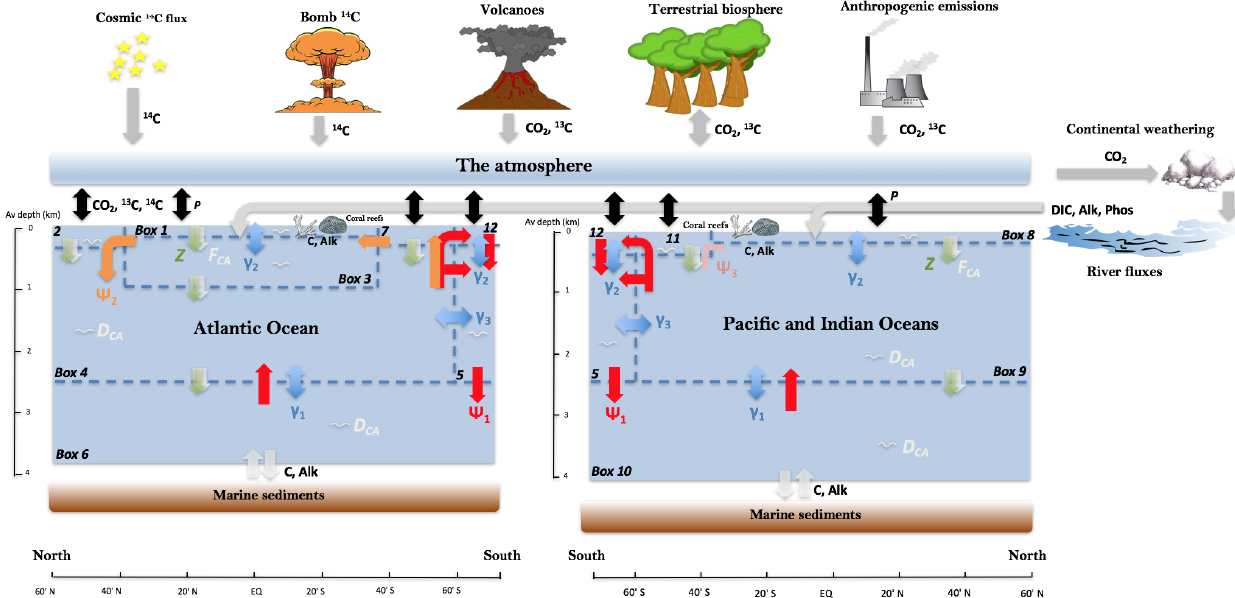
Figure 1. SCP-M configured as a 12-box ocean model plus atmosphere with marine sediments, continents and the terrestrial biosphere. Exchange of elemental concentrations occur due to fluxes between boxes. (cid:57) 1 (red arrows) is global overturning circulation (GOC), (cid:57) 2 (orange arrows) is Atlantic meridional overturning circulation (AMOC). GOC upwelling in both basins is set by default to a 50% split between upwelling into the subpolar and polar Southern Ocean. (cid:57) 3 (pink arrows) is Antarctic intermediate water (AAIW) and Subantarctic mode water (SAMW) formation in the Indian and Pacific oceans (e.g. Talley, 2013). Blue arrows represent mixing fluxes between boxes. γ 1 and γ 3 parameterize deep–abyssal and Southern Ocean deep topographically induced mixing (e.g. De Boer and Hogg, 2014), while γ 2 is low-latitude thermohaline mixing (e.g. Liu et al., 2016). Z (green downward arrows) is the biological pump, F CA (white downward arrows) is the carbonate pump, D CA (white squiggles) is carbonate dissolution and P (black, bidirectional arrows) is the air–sea gas